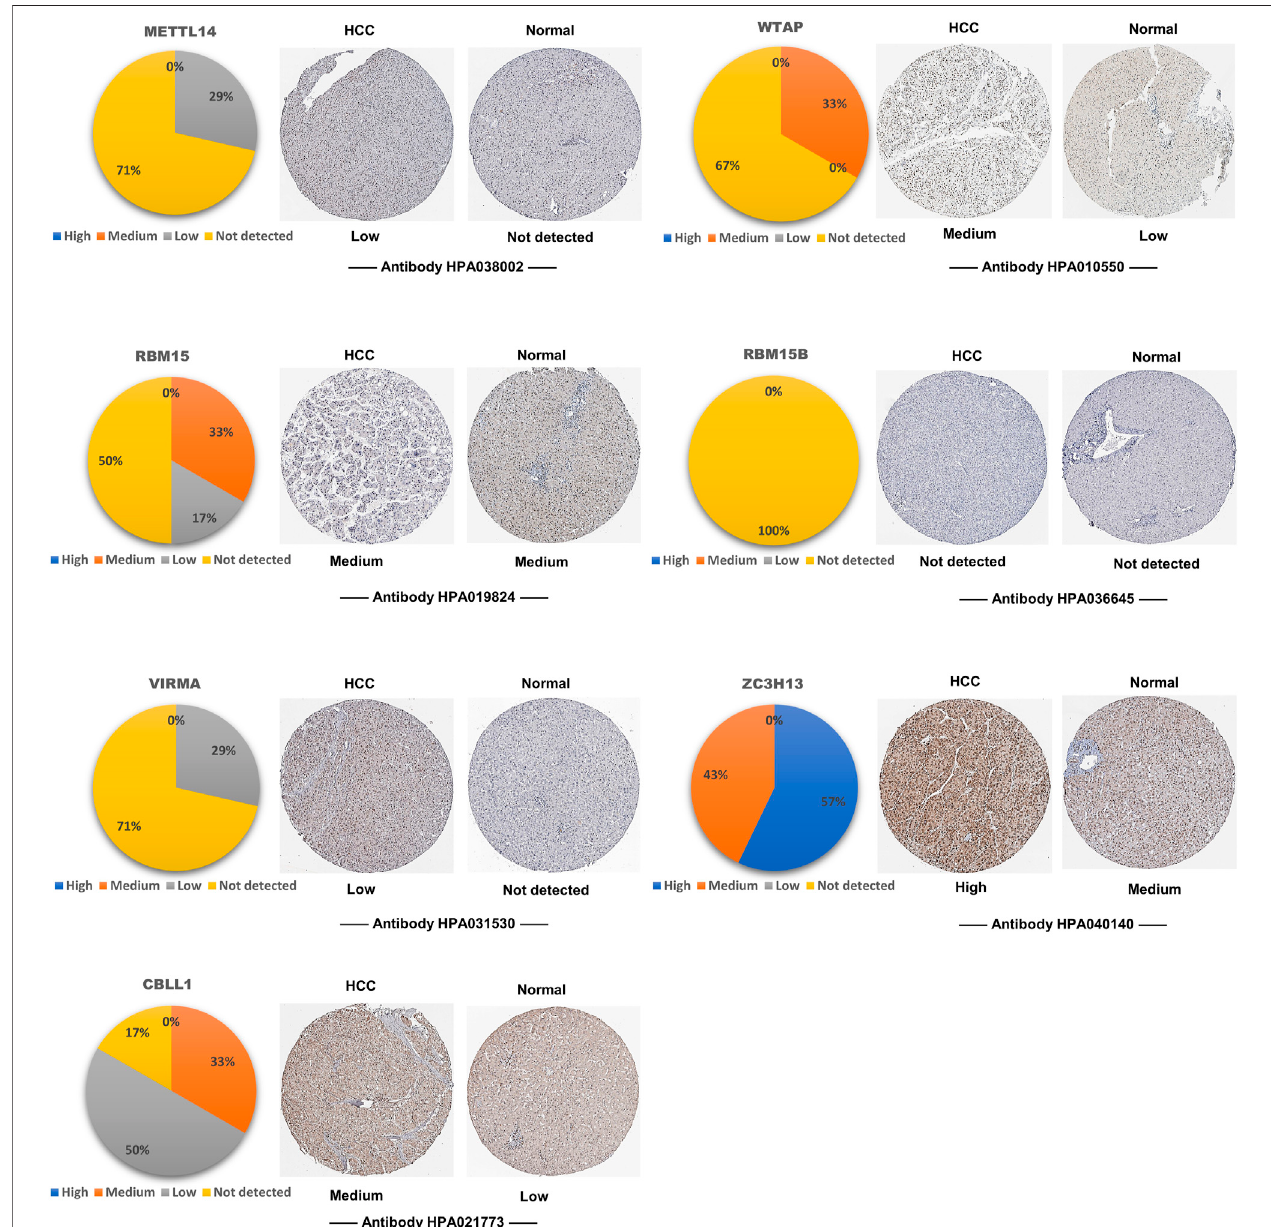
FIGURE 3 | Tissue levels of the m 6 A writer complex in HCC (HPA). Representative immunohistochemistry (IHC) images of the m 6 A writer complex in HCC tissues. METTL3 data is temporarily missing in HPA database. The pie chart shows the proportion of IHC staining differences in HCC tissues. Only images with the most prominent tissue expression are